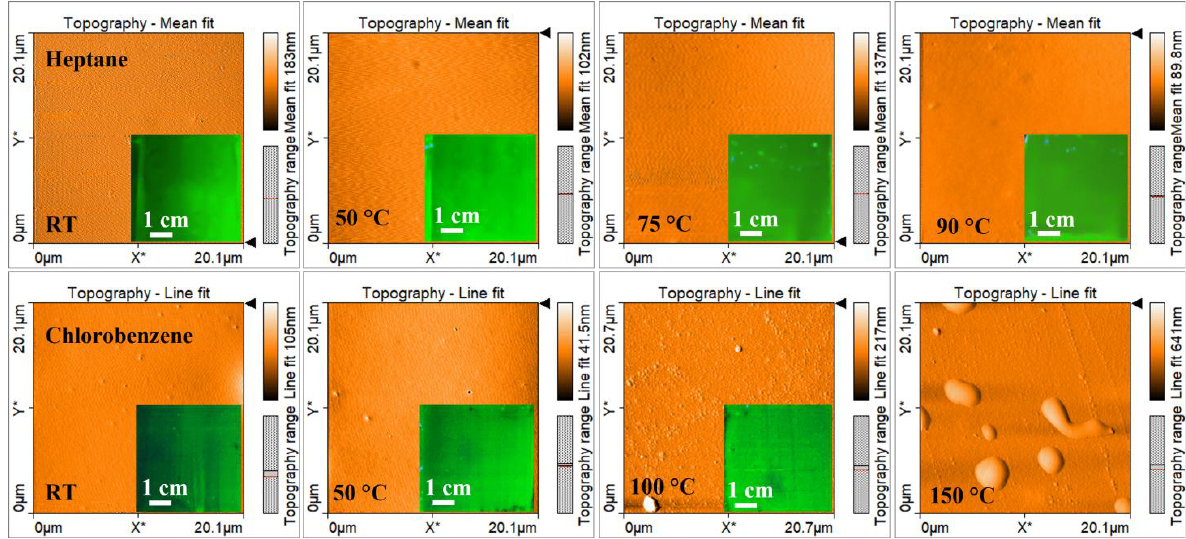
Figure 1. Representative AFM images of compound B films deposited by the blade coating technique with heptane and chlorobenzene as solvent. The inset is pictures of the films under UV light. On the other hand, when the solvent polarity changes by using DMF, films with coverage over the whole substrate are obtained only at RT, while agglomerates of several sizes were formed when the temperature rose. For RT, the solution is bladed over the substrate surface, and owing to the high boiling point of DMF, no solvent evaporation occurs until the substrate is transferred to the hot plate. Therefore, despite having a complete spreading of solution over the whole substrate, a non-homogeneous film with thicker and thinner zones is obtained (inset in RT Figure, Figure 2). When the substrate and DMF solution are heated before deposition, aggregates are formed onto the substrate instead of a homogeneous film. Solution deposited at 50 °C showed larger aggregates in the range of micrometers; at this temperature, solvent evaporation has begun but not fast enough, allowing larger drops onto the surface. Increasing the temperature reduces the aggregate size because it also increases the solvent evaporation rate; at 100 °C and 150 °C, films composed of nanoaggregates were observed (Figure 2). Figure 2. Representative AFM image for films deposited with DMF as solvent. The inset is pictures of the films under UV light. In the case of acetonitrile and MeOH, aggregates were formed on the surface inde- pendently of the deposition temperature (Figures 3 and S2, S4, and S6). As observed with DMF, the acetonitrile and MeOH aggregates are smaller as the temperature increases. In this case, the observed morphology could be due to faster solvent evaporation because of the high vapor pressure, which avoids film formation.